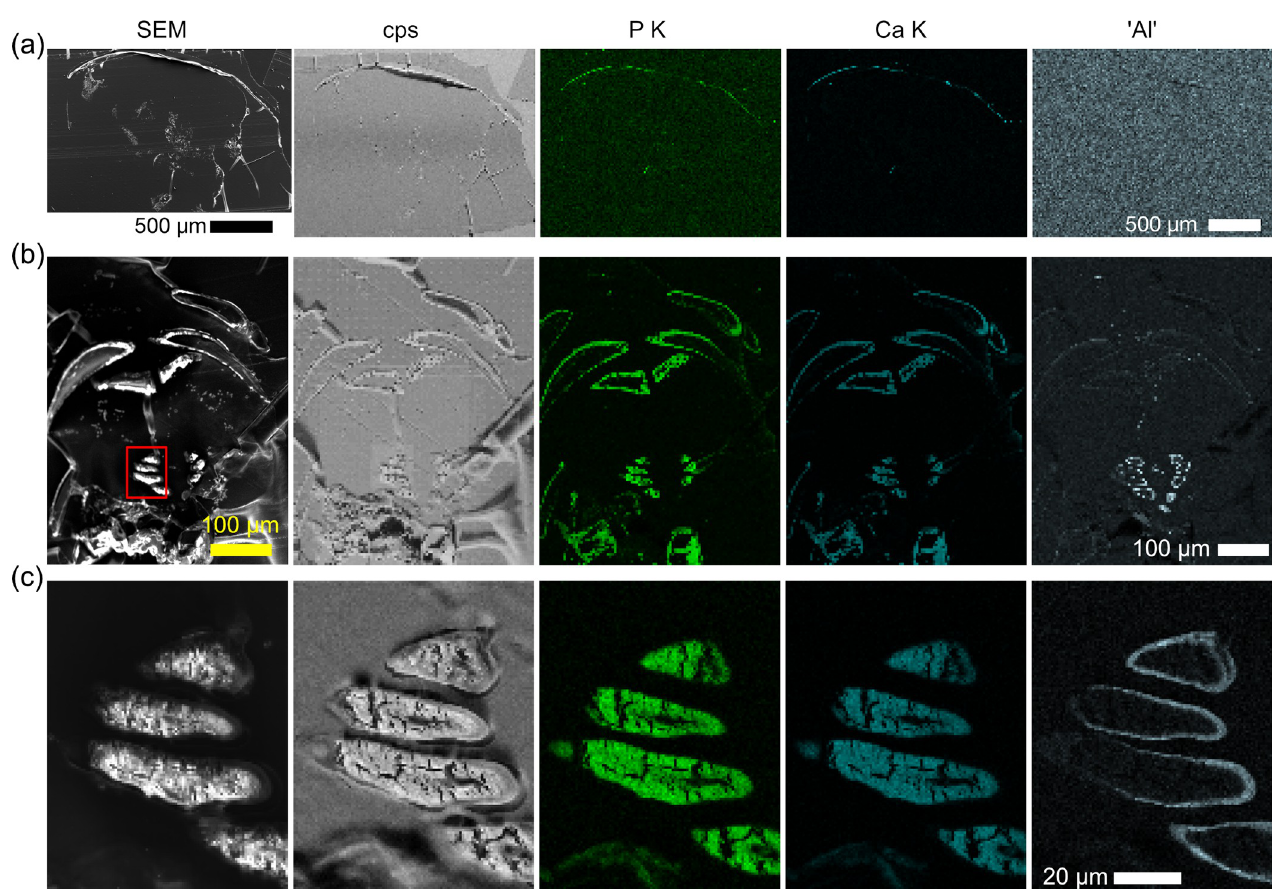
Fig 2. EDS maps of semi-thin sections of H . gigas . a) Transverse section through a subsample of pereonite. b) Transverse section of the cephalic region showing the gastric mill. c) Magnified images of the gastric mill, the red rectangle area in (b). Images from the left are SEM images at (a,b) 1 kV and (c) 10 kV, total X-ray counts (grayscale), phosphorous (green), calcium (blue), and aluminum-like signals around 1.48 keV (silver). EDS spectra were acquired at 10 kV, thus the K-line of bromine was not